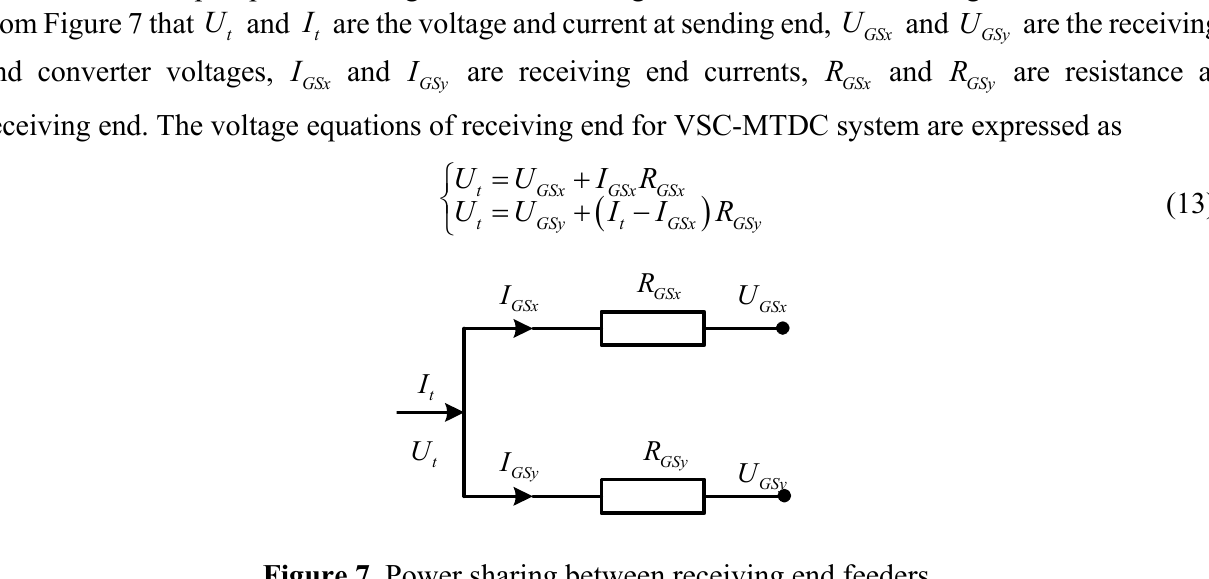
Figure 7. Power sharing between receiving end